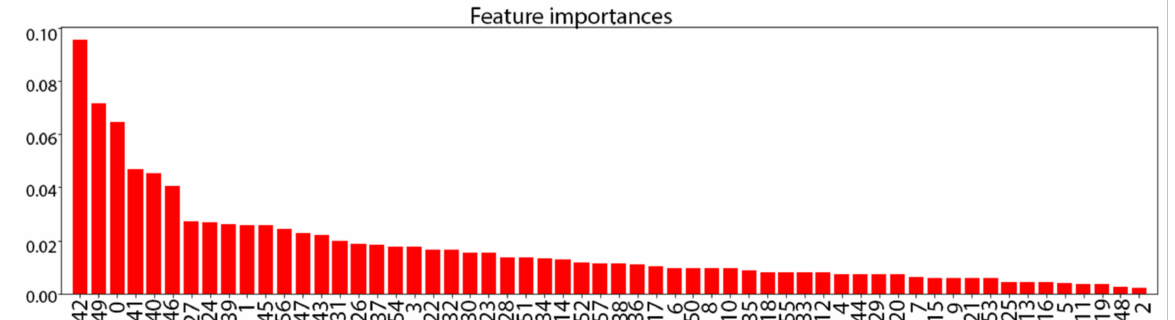
Figure A2. Feature importance for W-TSS shapelets predicting days with and without inhaler use in